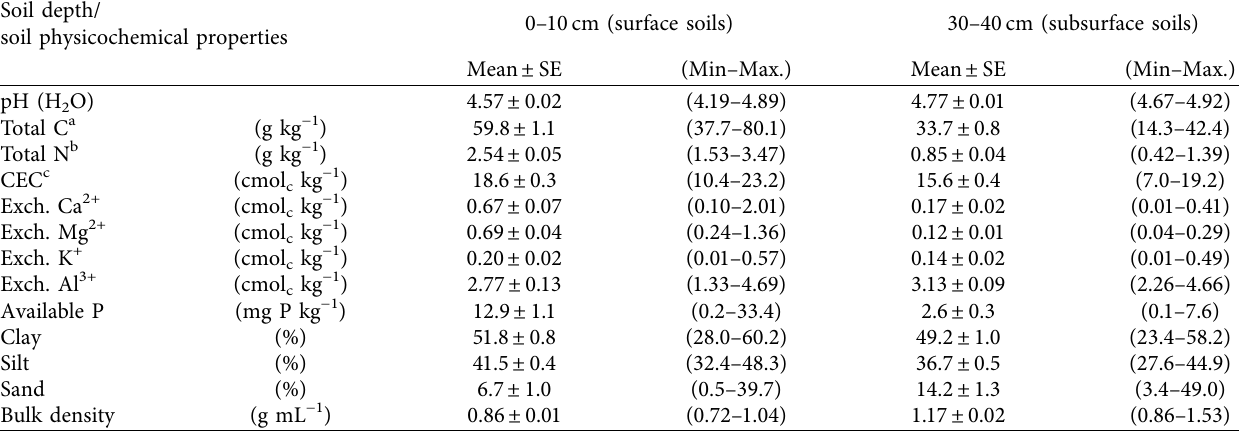
Table 1: Means and standard error of initial surface and subsurface soil physicochemical characteristics of the experimental planting sites at Sampadi Forest